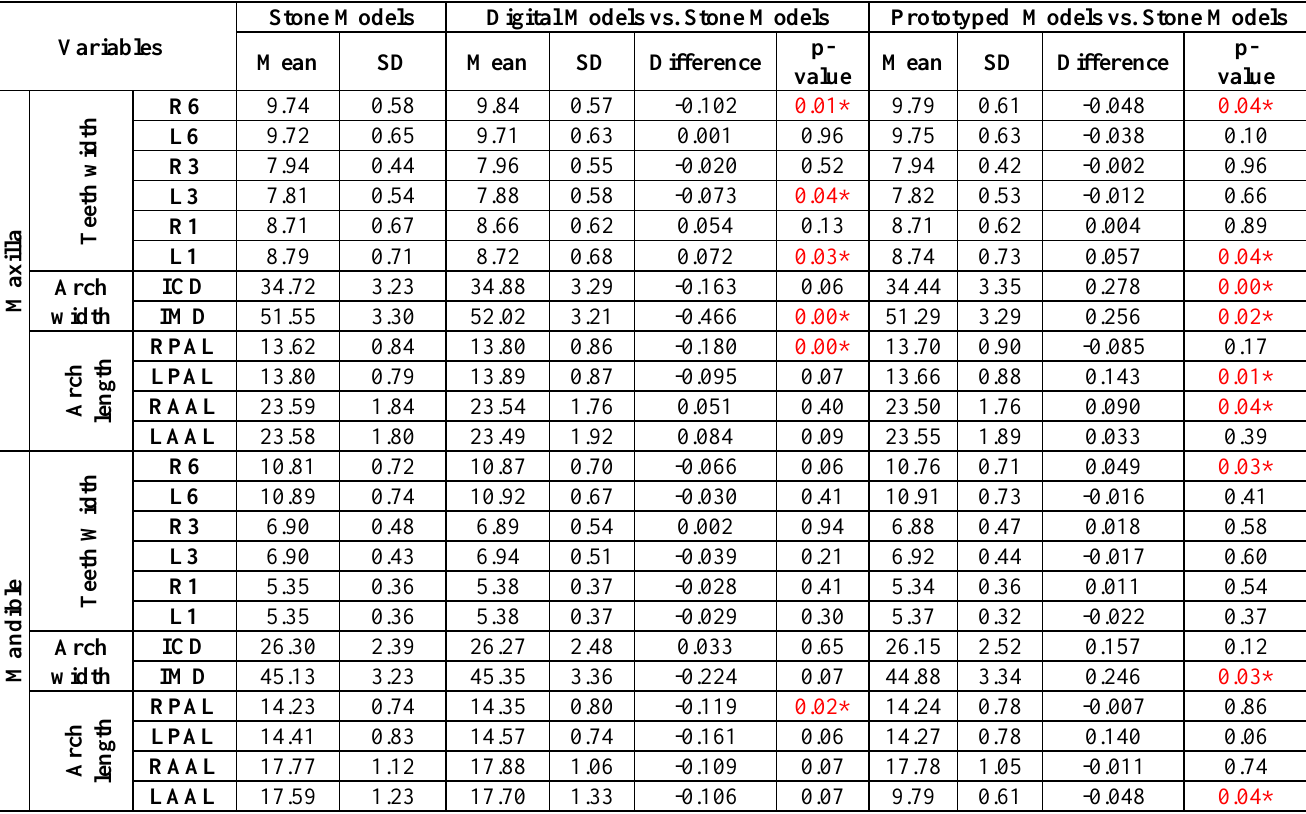
Table 1: Descriptive data and paired sample